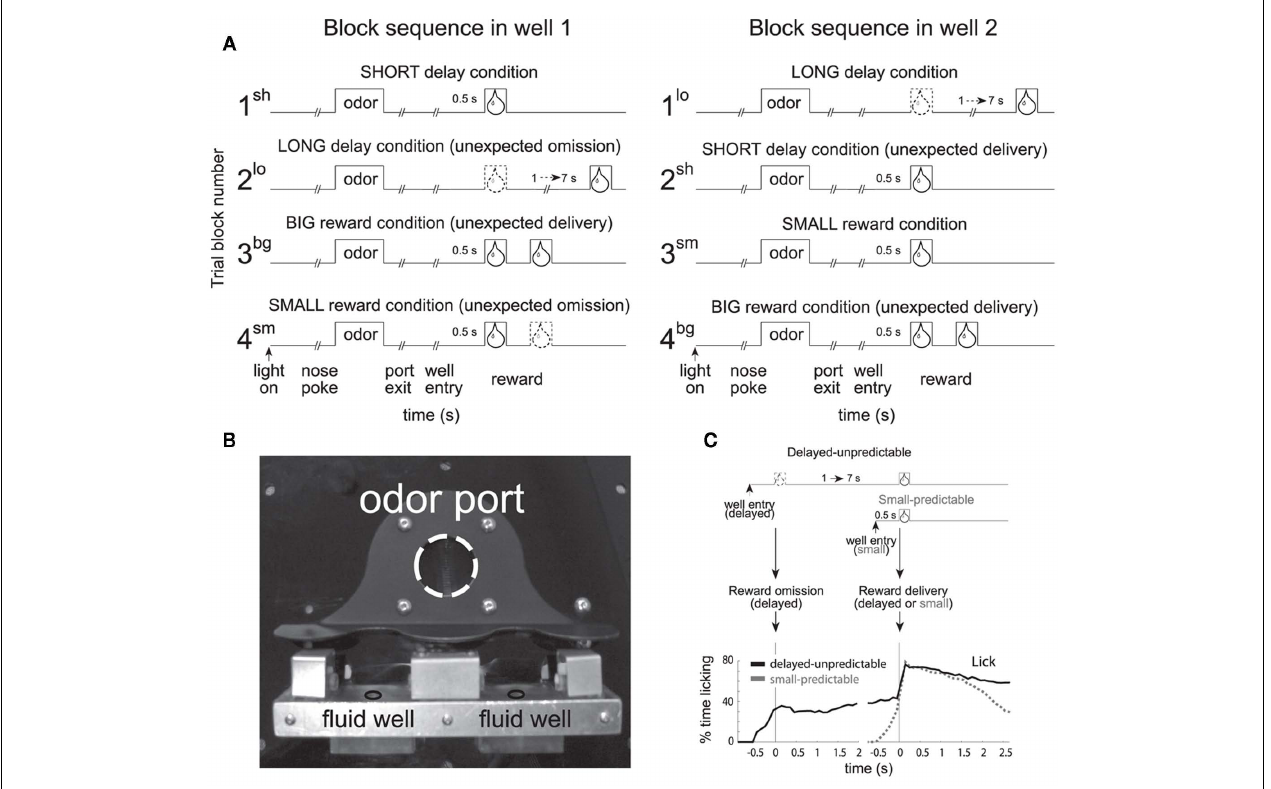
could obtain reward at either well. At the start of each recording session one well was randomly designated as short (a 0.5s delay before reward) and the other long (a 1 to 7s delay before reward) (block 1). In the second block of trials these contingencies were switched (block 2). In blocks 3 and 4 delays were held constant (0.5s) and reward size was manipulated. sh = short; bg = big; lo = long; sm = small; (B) Picture of apparatus. (C) Percent licking behavior averaged over all recording sessions during trials when a small reward was delayed versus when a small reward was delivered after 0.5s. Licking is aligned to well entry (left) and reward delivery (right). Adapted from (Roesch et al., 2006, Roesch et al., 2007b,Takahashi et al.,